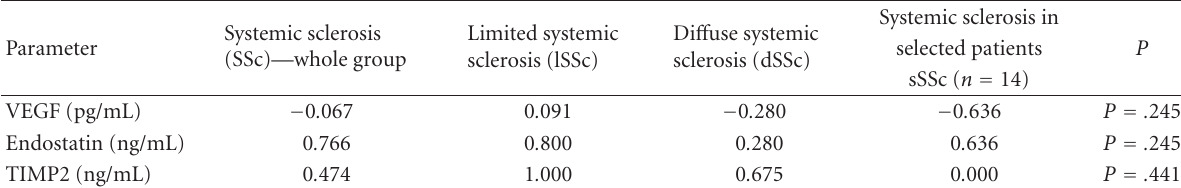
Table 2. Correlations between vascular endothelial growth factor (VEGF), endostatin, and tissue inhibitor of metalloproteinases 2 (TIMP2) serum levels and heart involvement in the di ff erent groups examined (Fisher precisely test, coe ffi cient Q ); n is the number of the patients; P is the statistical significance at P < . 05.